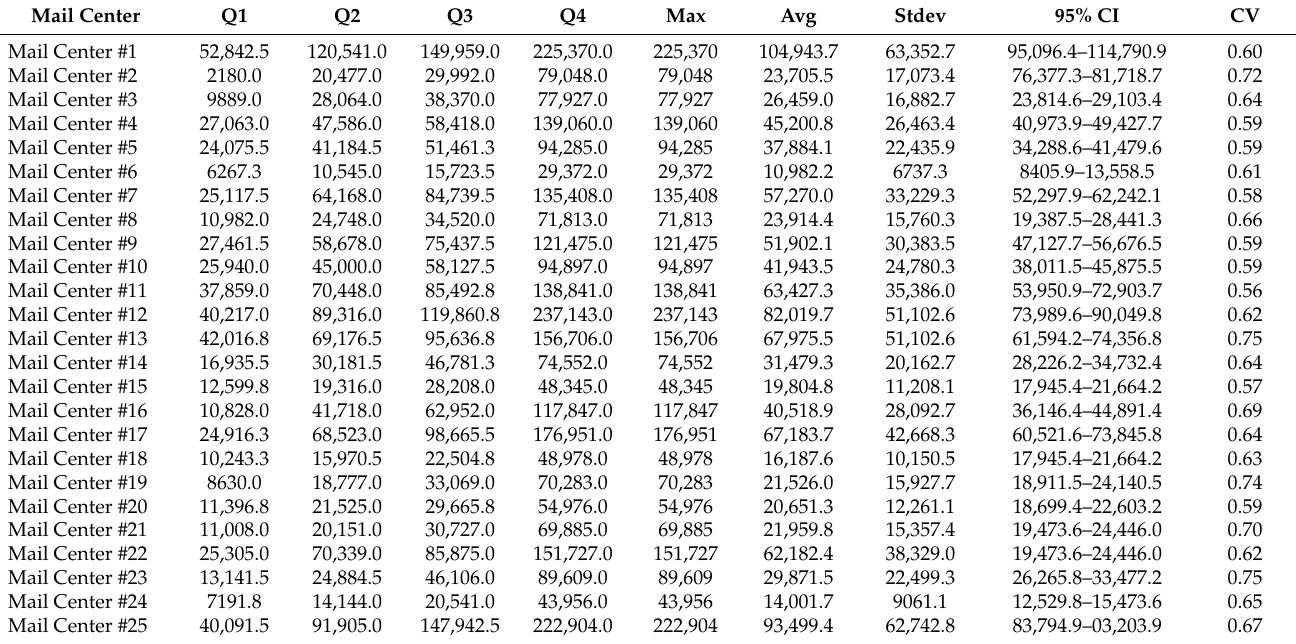
Table 1. Summary of datasets of peak periods in 25 mail centers .